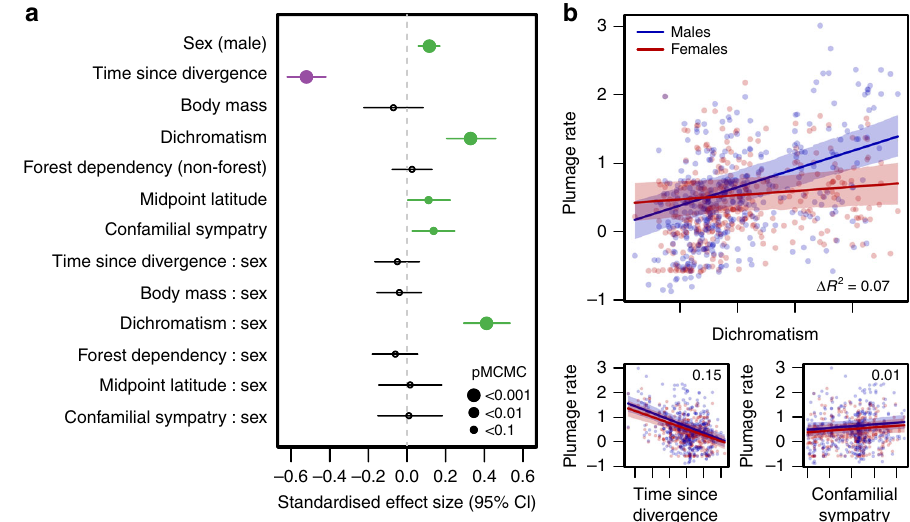
Fig. 2 Predictors of rates of plumage colour evolution in the Tyrannida. a Coef fi cient estimates from a multipredictor BPMM predicting variation in (log 10 transformed) whole-plumage TR ES rates of colour evolution among Tyrannida species ( n = 372). Points indicate the mean standardised effect sizes for each of the (scaled) predictor variables and lines indicate 95% credible intervals (CI). Predictors with signi fi cant ( pMCMC < 0.05) effects are coloured purple (negative effect) and green (positive effect). Marginal R 2 value (i.e., variance explained by fi xed factors) for the full model is 0.23. b Scatterplots showing the relationship between signi fi cant predictor variables and plumage rates with regression lines (and 95% CIs) plotted for males (blue) and females (red) separately. Inset values show the change in marginal R 2 ( Δ R 2 ) relative to the full model when a given predictor (and its interaction with sex) is dropped from the full